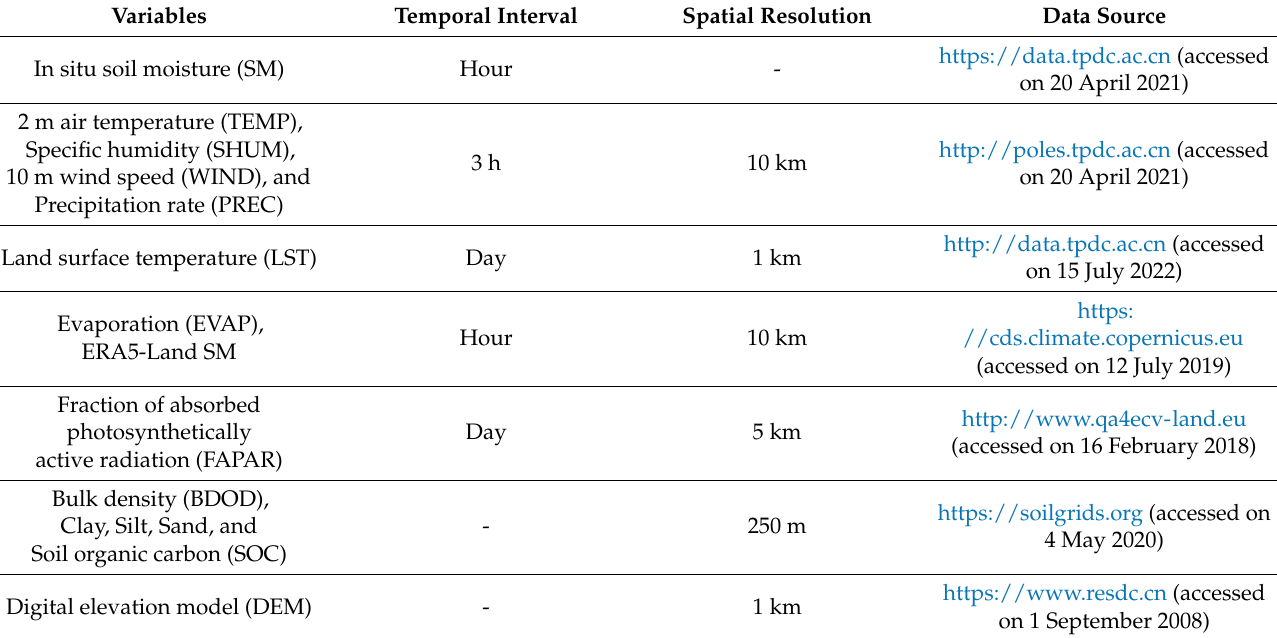
Table 1. Datasets used in this